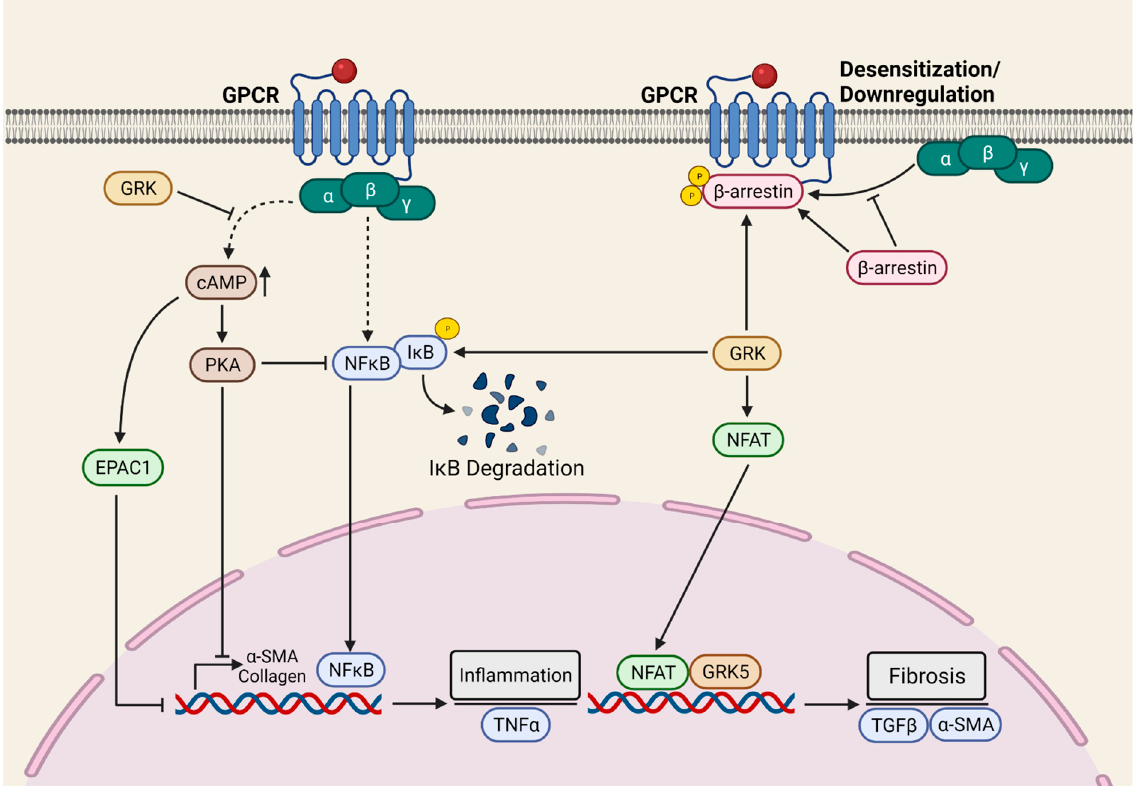
Figure 3. GPCR-mediated myocardial pro-fibrotic signaling . The G-protein-coupled receptor kinases (GRKs) are crucial for GPCR signaling. GRKs are the critical positive regulator of fibroblast activation and myocardial fibrosis. GRKs mediate pro-fibrotic effects by modulating cAMP levels and NF- κ B signaling. Furthermore, GRKs interact with NFAT to potentiate NFAT: DNA binding, thereby inducing the transcription of NFAT-mediated fibrotic genes. α -SMA = Alpha-smooth muscle actin; cAMP = Cyclic adenosine monophosphate; EPAC = Exchange protein activated by cAMP; GRK = G-protein-coupled receptor kinases; IkB = Inhibitor of NF- κ B; NFAT = Nuclear factor of activated T-cells; NF κ B = Nuclear factor-kappa B; PKA = Protein kinase A; TGF- β 1 = Transforming growth factor beta 1; TNF = Tumor necrosis factor.